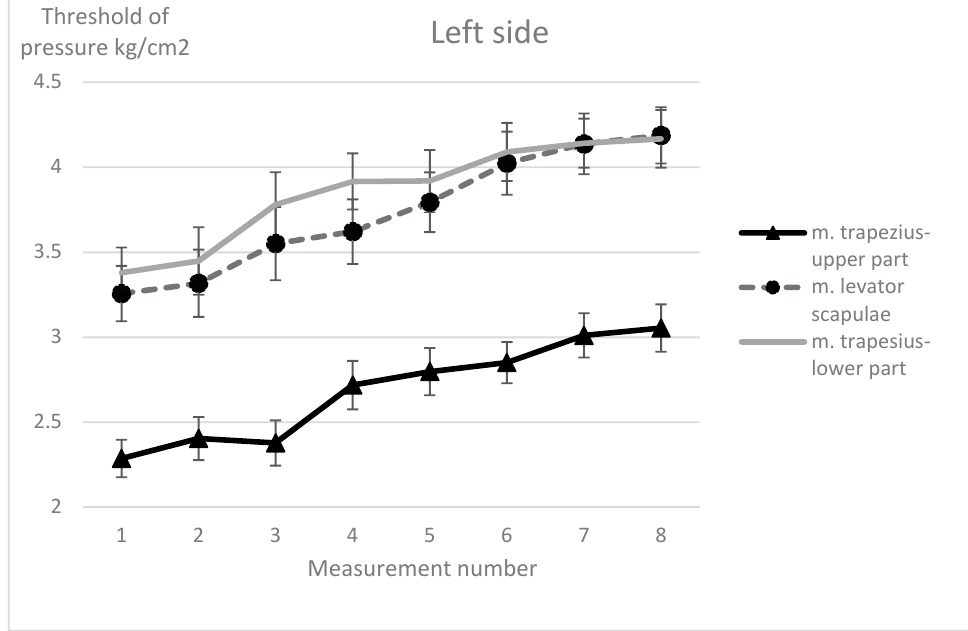
Figure 4. Changes in pain sensitivity of the examined muscle trigger points on the left side (Mean, SE).